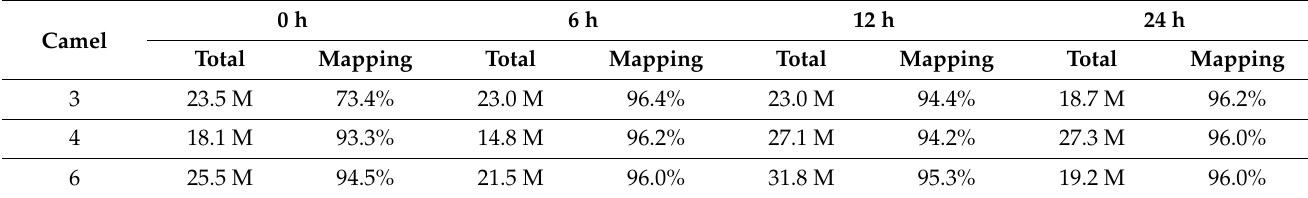
Table 2. Read-related metrics for the sequencing samples used in this study. Both the number of reads and the number of high-quality mappings refer to paired-end reads.